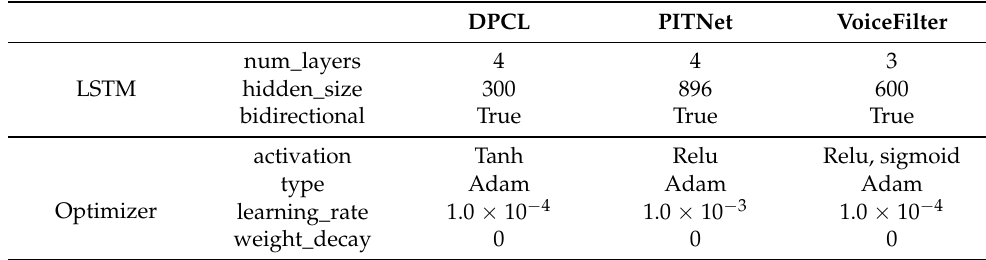
Table 1. Configurations of three speech separation